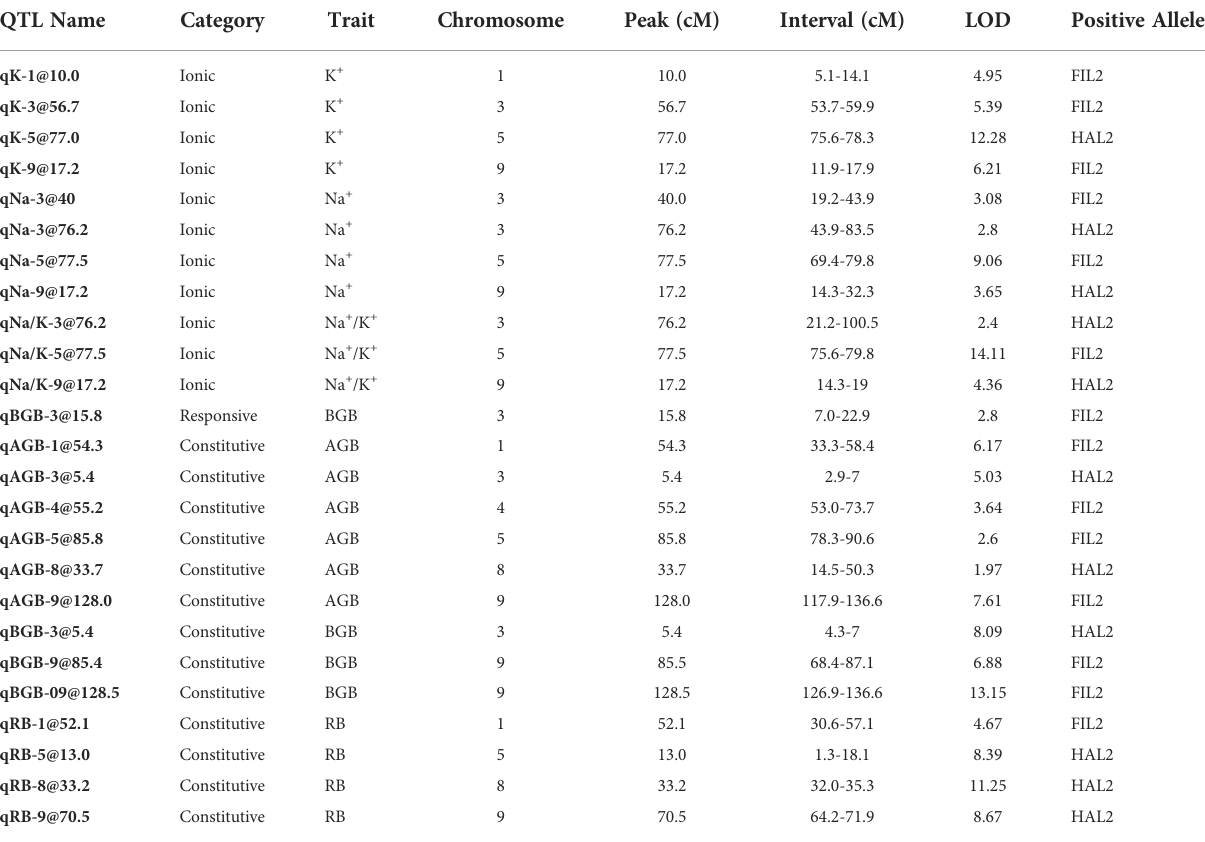
TABLE 1 List of QTL for Constitutive, Responsive and Treatment Categories. QTL